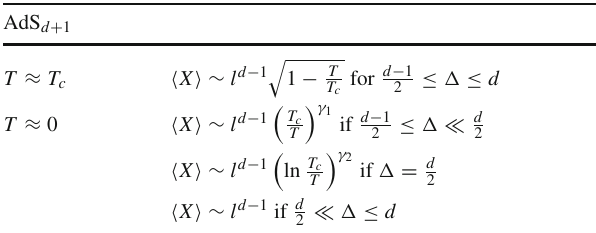
Table 2 (cid:3) X (cid:4) := (cid:3) O (cid:2) (cid:4) , near T = T c and T = 0 T (cid:2) c d − 2 + 2 (cid:2))